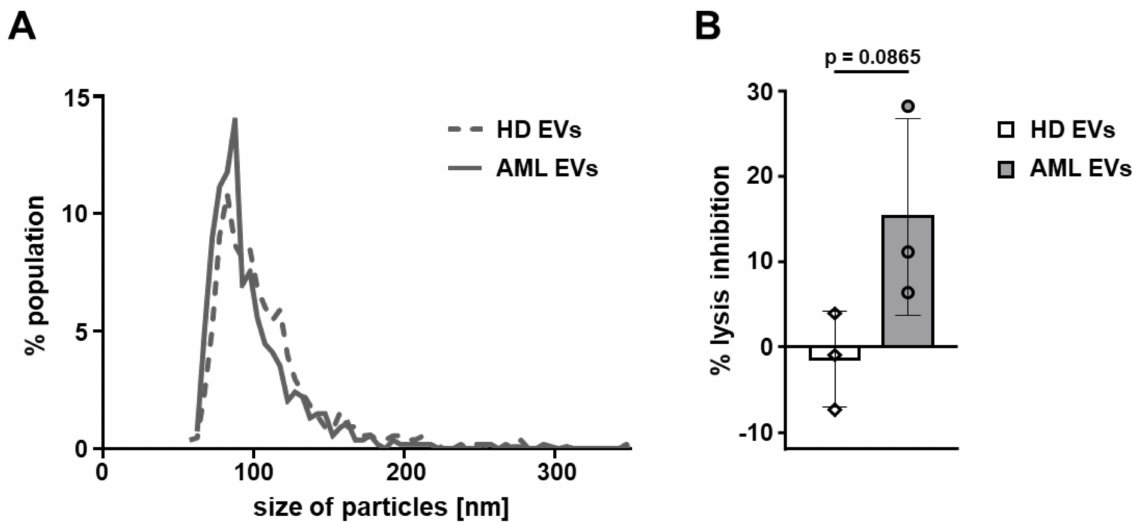
Figure A4. Size distribution and inhibitory capacity of EVs isolated from human plasma. EVs were isolated from plasma of AML patients and healthy donors (HD) using size exclusion chromatography (SEC). ( A ) Mode size distribution of primary EVs as determined by TRPS using a 150 nm pore. ( B ) Inhibition of K-562 target cell lysis by PBMCs treated with primary EVs at a ratio of 15,000:1 EVs:PBMCs. Abbreviations: AML, acute myeloid leukemia; EVs, extracellular vesicles; HD, healthy donor; PBMCs, peripheral blood mononuclear cells from healthy donors. (Unpaired Student’s t -test; n = 3 independent donors, symbols represent individual